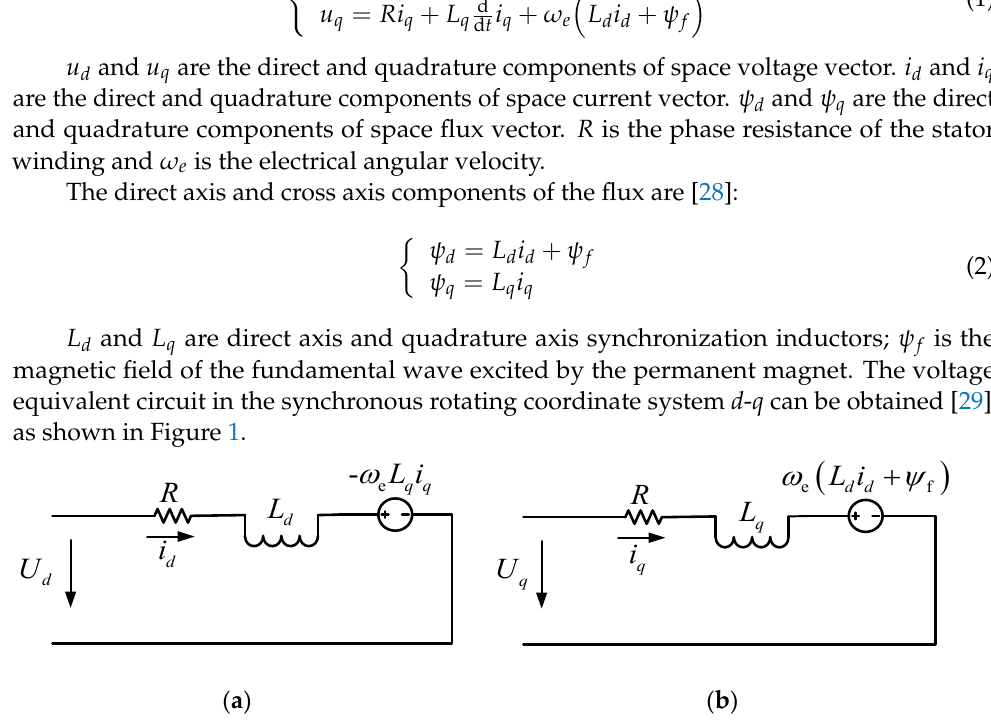
Figure 1. Equivalent winding diagram of PMSM in d - q coordinate system. ( a ) d axis equivalent circuit. ( b ) q axis equivalent circuit.